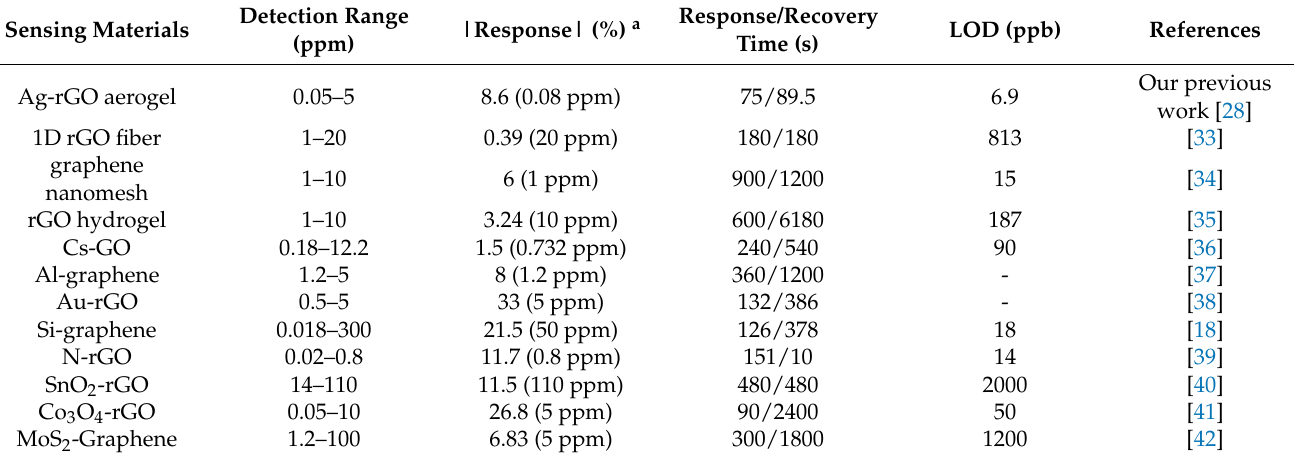
Table 1. NO 2 sensing performance comparison of graphene-based materials in recent experimental works.